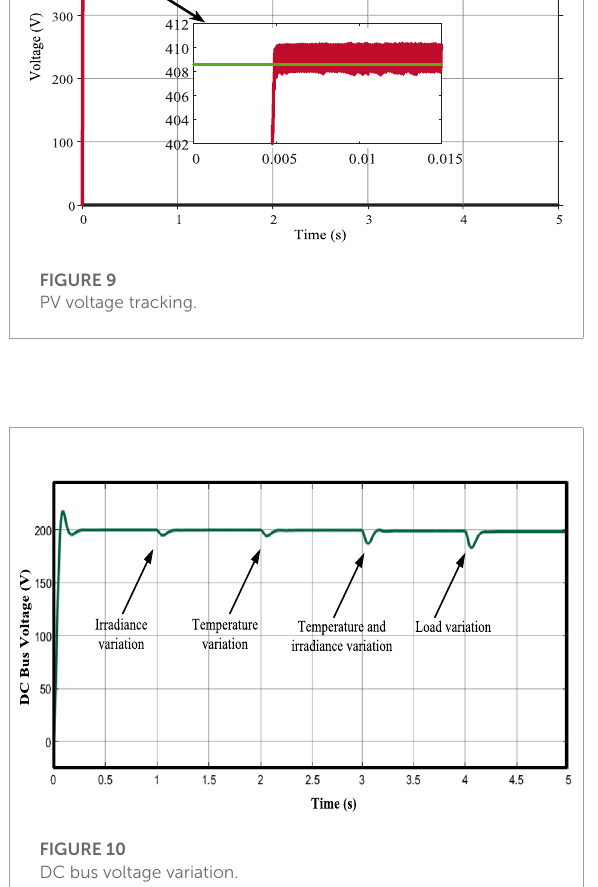
FIGURE 10 DC bus voltage